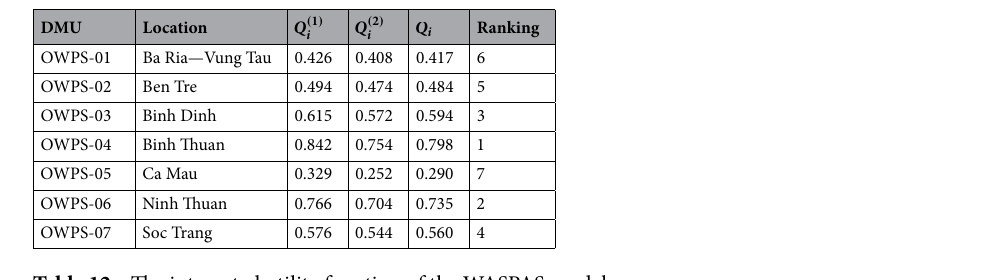
Table 12. The integrated utility function of the WASPAS model.